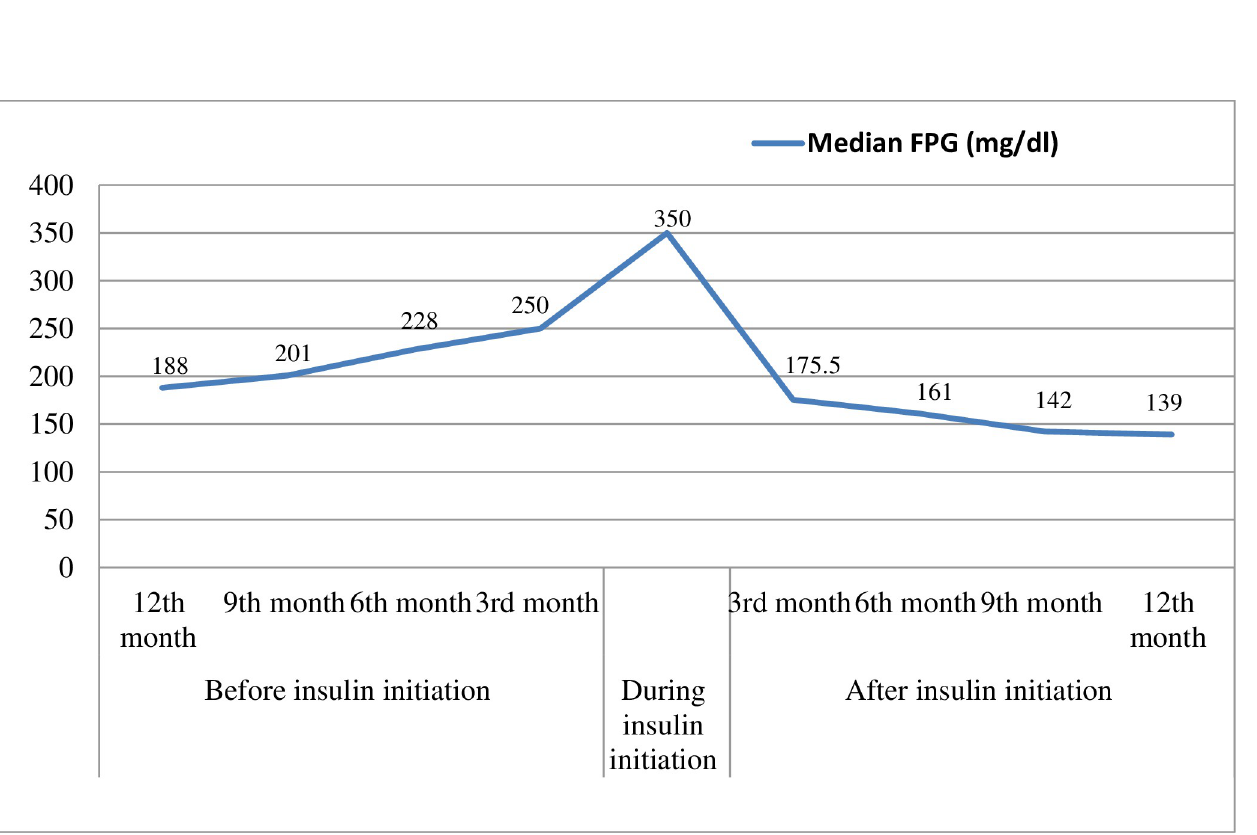
PLOS ONE | https://doi.org/10.1371/journal.pone.0268639 May 26,